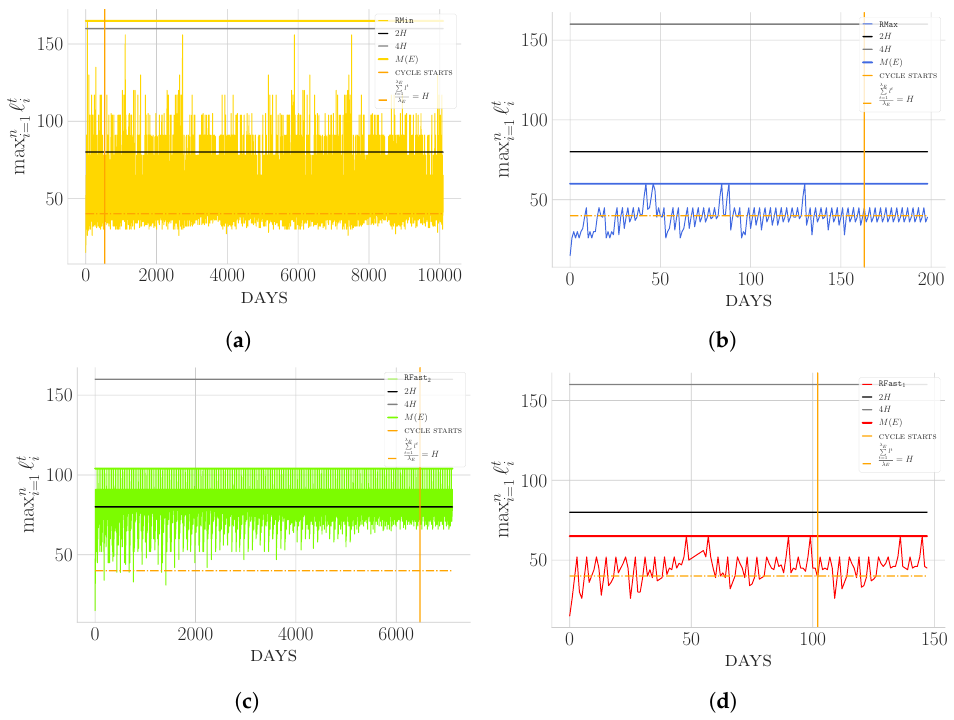
Figure 11. Snapshot of the evolution of maximum heights when strategies: RMin ( a ); RMax ( b ); RFast 2 ( c ); and RFast 1 ( d ) are applied on an instance having n = 10 and H = 40 (in details, structured as follows [ 15;13;4;2;1;1;1;1;1;1 ] ). Data are plotted as in Figure